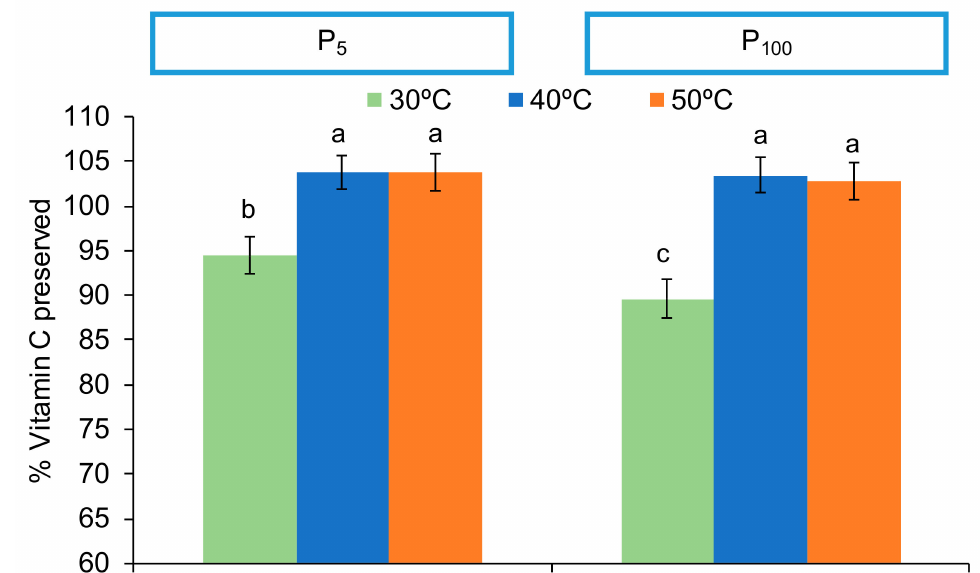
Figure 5. Percentage (%) of preserved vitamin C (mean and Tukey’s HSD) according to the interaction between shelf temperature (30, 40 or 50 ◦ C) and pressure (P 5 : 5 Pa and P 100 : 100 Pa) factors. Di ff erent letters indicate di ff erent homogeneous groups for the temperature*pressure interaction ( p < 0.05). Data of both freezing rates are considered in the mean